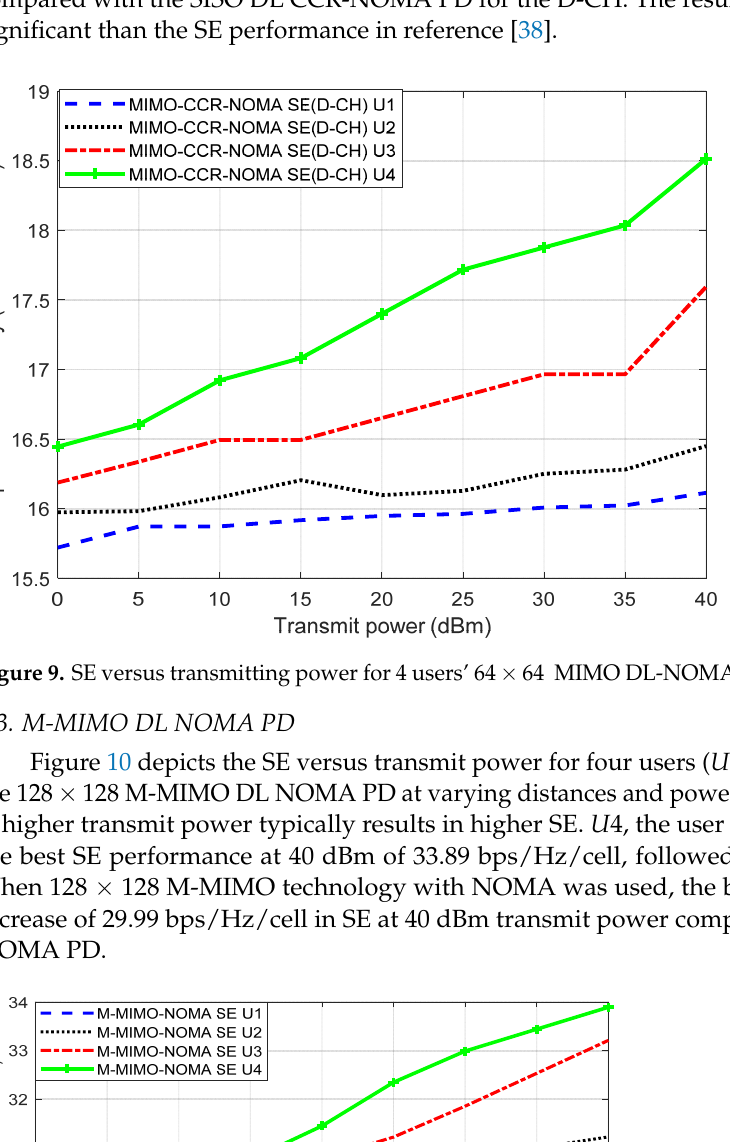
Figure 11. SE against transmitting power for 4 users’ 128×128 M-MIMO DL NOMA PD with C-CH CCRN.